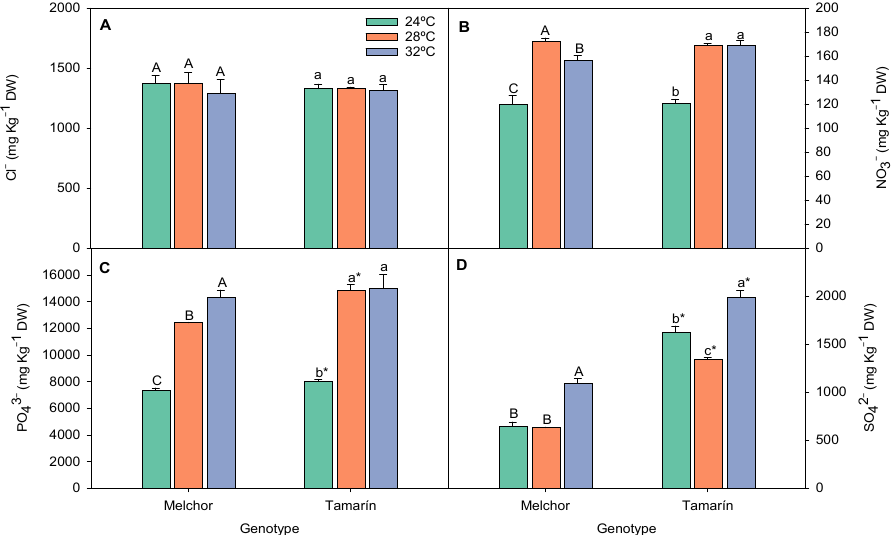
Figure 5. Effect of temperature (24 °C, 28 °C, and 32 °C) on anions content: ( A ) chlorides (Cl − ), ( B ) nitrates (NO 3 − ), ( C ) phosphates (PO 43 − ), and ( D ) sulfates (SO 42 − ) of Melchor and Tamarín fruits. The data are presented as the treatment means ( n = 6) ± S.E. Different lowercase letters indicate signifi- cant differences between temperatures in Melchor and different uppercase letters indicate signifi- cant differences between temperatures in Tamarín. * Denotes significant differences between two cultivars grown under the same temperature conditions. Table 4. Effect of temperature (24 °C, 28 °C, and 32 °C) on cation concentrations (K, Mg, Ca, Fe, Cu, Mn, Zn, and B) of Melchor and Tamarín fruits.